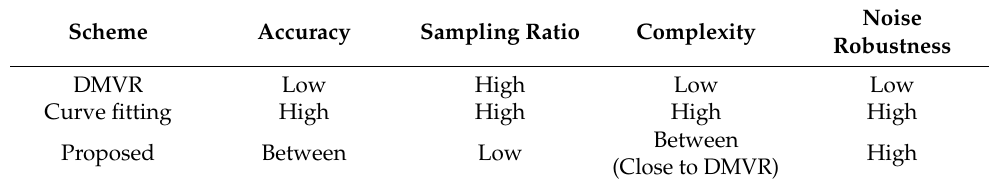
Table 1. Comparison of different